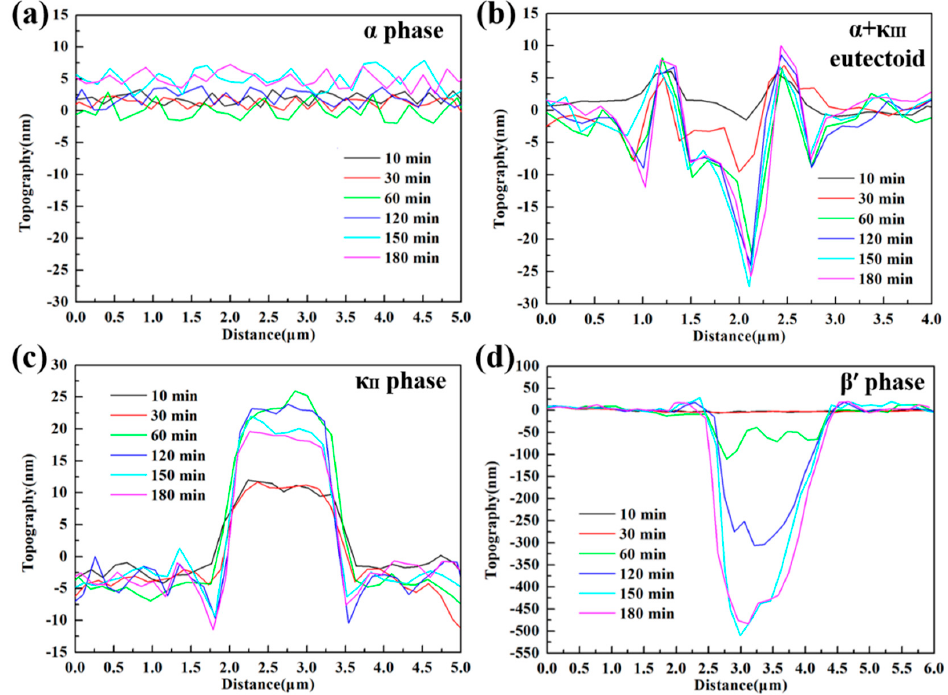
Figure 10. In-situ line profiles corresponding to sites 1, 2, 3, and 4 marked in Figure 9, respectively: